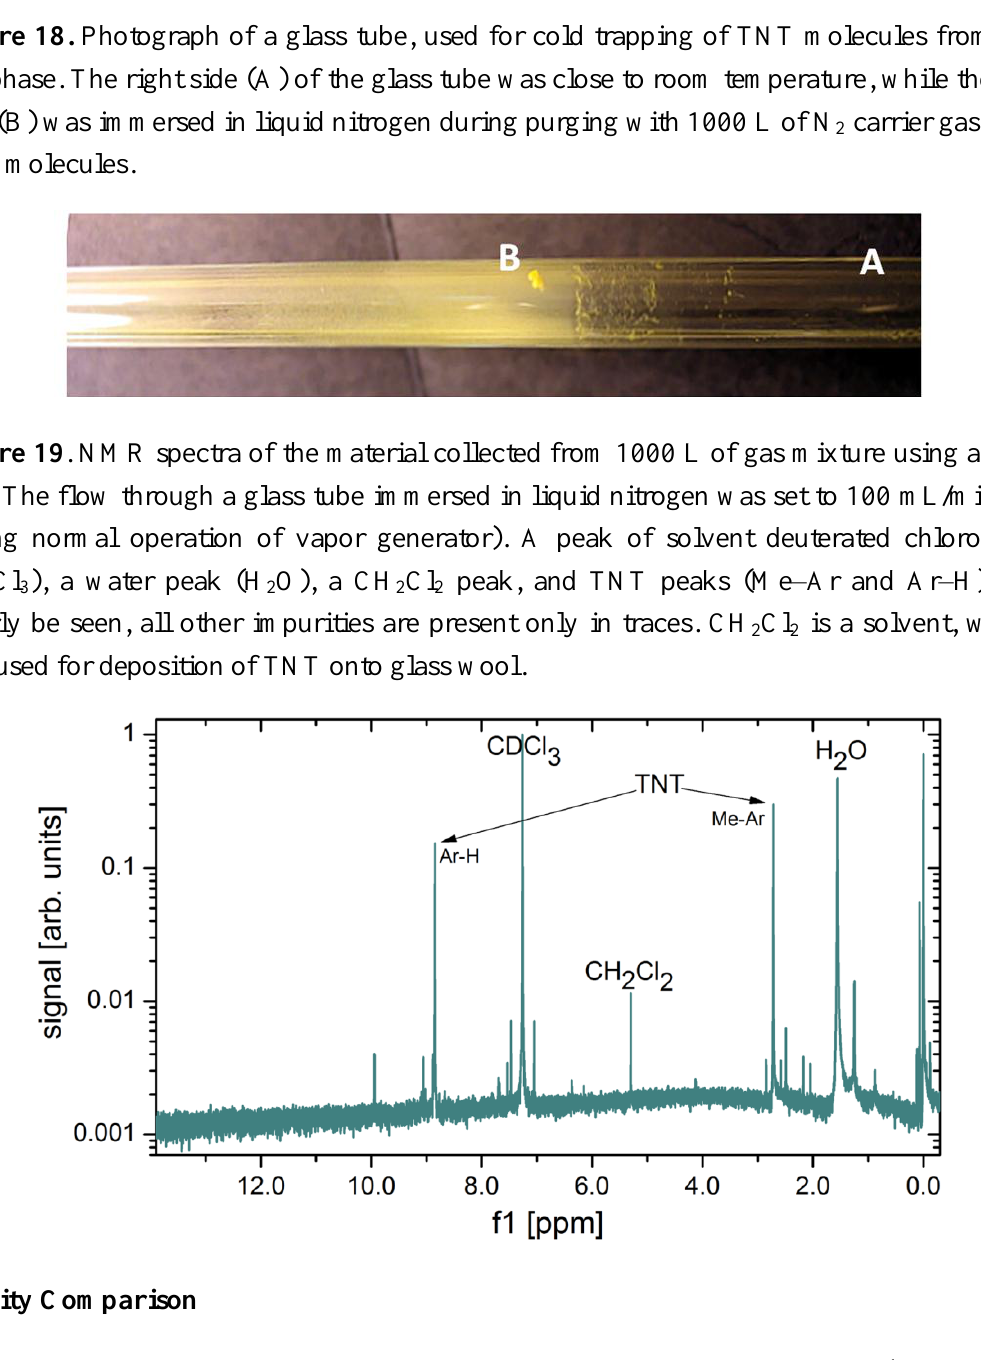
carrier gas with 2